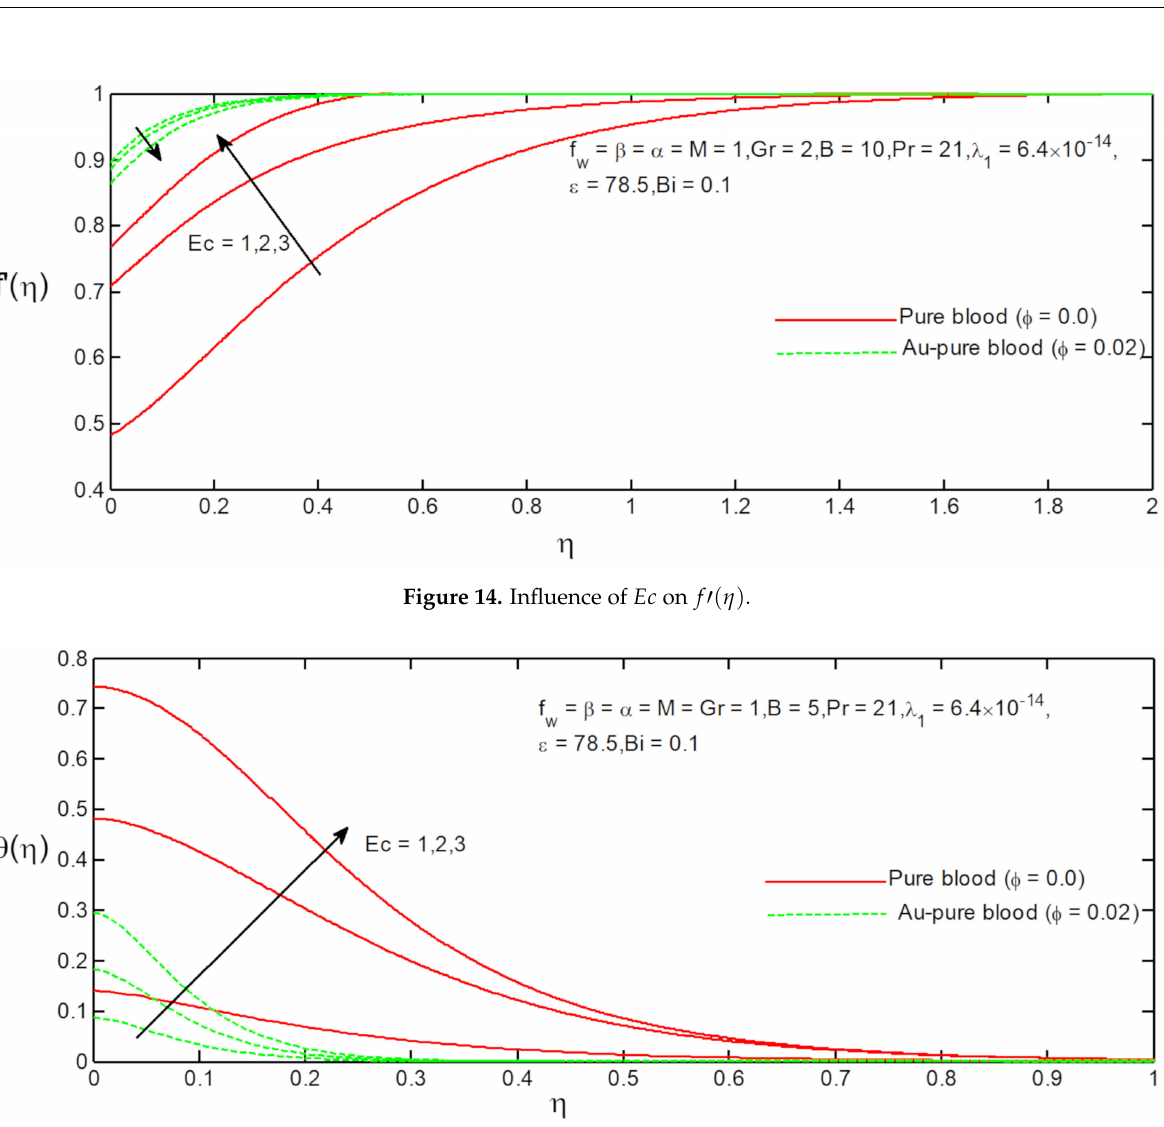
Figure 15. Influence of Ec on θ ( η )